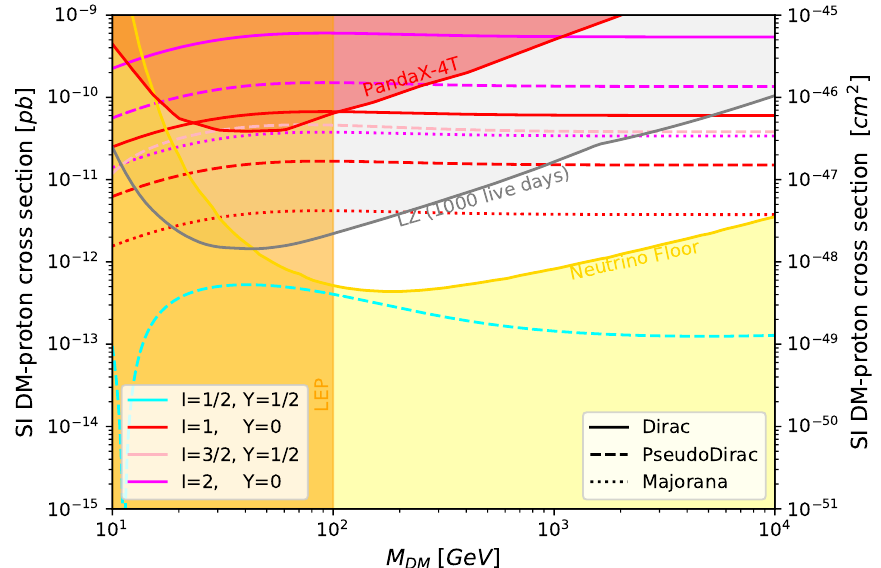
Figure 6. The SI DM-proton cross section for a single fermion multiplet, for surviving cases I ≤ 2 for which the neutral component is the lightest. The cases for Dirac multiplet with Y 6 = 0 are not shown, since they are excluded by direct detection via Z -boson